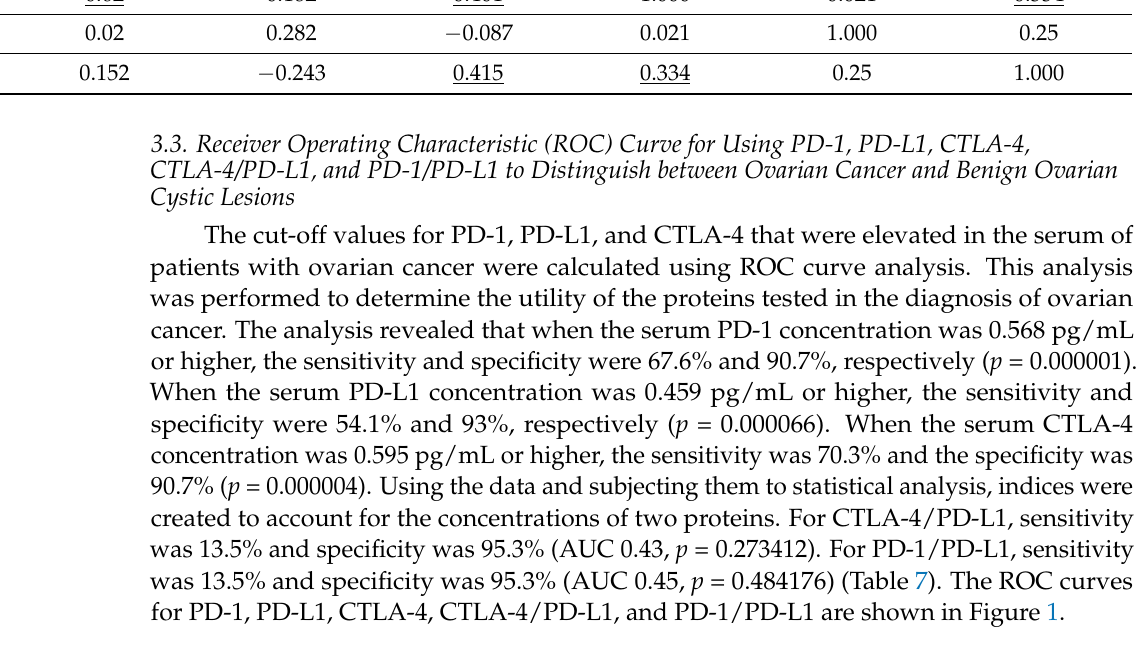
Table 7. The diagnostic values of PD-1, PD-L1, CTLA-4, CTLA-4/PD-L1, and PD-1/PD-L1 for patients with ovarian